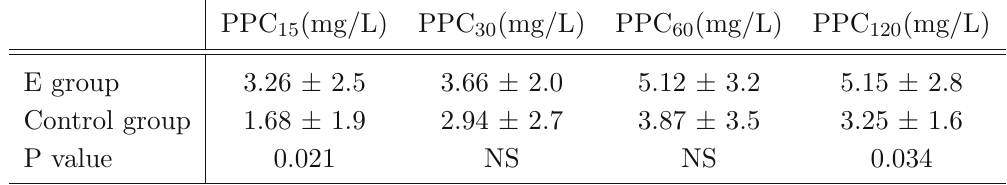
Table 2 Relationship between plasma paracetamol concentration (PPC) in the control group C and E group (early postoperative gastric supply of nutritients).